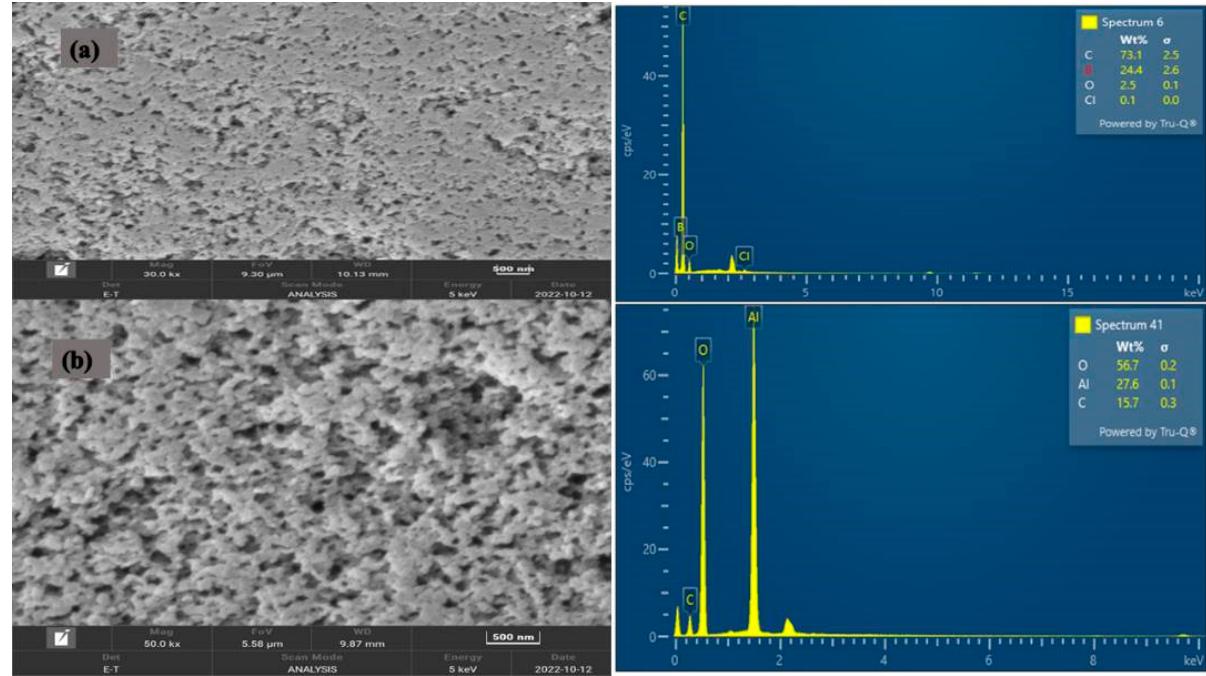
Figure 3. FESEM and EDX of ( a ) Before loading CRB05 ( b ) After loading CRB05.